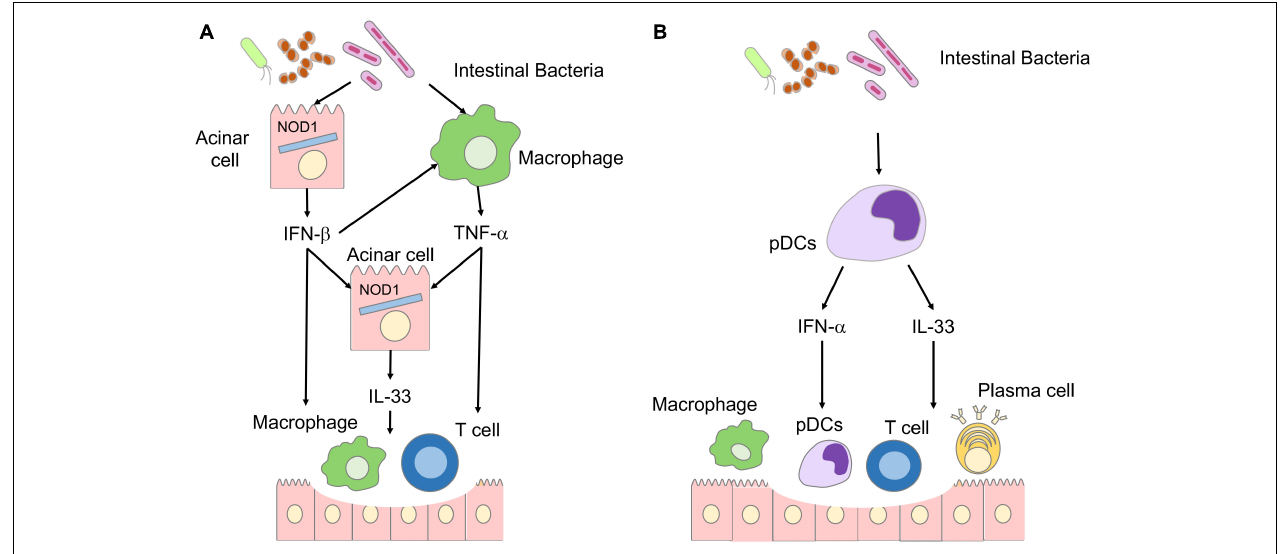
FIGURE 2 | Involvement of IL-33 in the immunopathogenesis of chronic pancreatitis (CP) and autoimmune pancreatitis (AIP). (A) Involvement of IL-33 in the immunopathogenesis of CP. Disruption of the intestinal barrier accompanied by pancreatitis induces translocation of intestinal bacteria into the pancreas. Nucleotide-binding oligomerization domain 1 (NOD1) expressed in pancreatic acinar cells recognizes intestinal bacteria. Pancreatic acinar cells produce IFN- β through synergistic activation of signaling pathways mediated by NOD1 and cholecystokinin receptor. Pancreatic macrophages produce TNF- α in response to IFN- β . IL-33 is produced by pancreatic acinar cells in a TNF- α - and IFN- β -dependent manner. The IFN- β -IL-33 axis underlies the immunopathogenesis of CP. (B) Involvement of IL-33 in the immunopathogenesis of autoimmune pancreatitis. Intestinal dysbiosis activates pancreatic plasmacytoid dendritic cells (pDCs) producing IFN- α and IL-33. The IFN- α -IL-33 axis underlies the immunopathogenesis of autoimmune